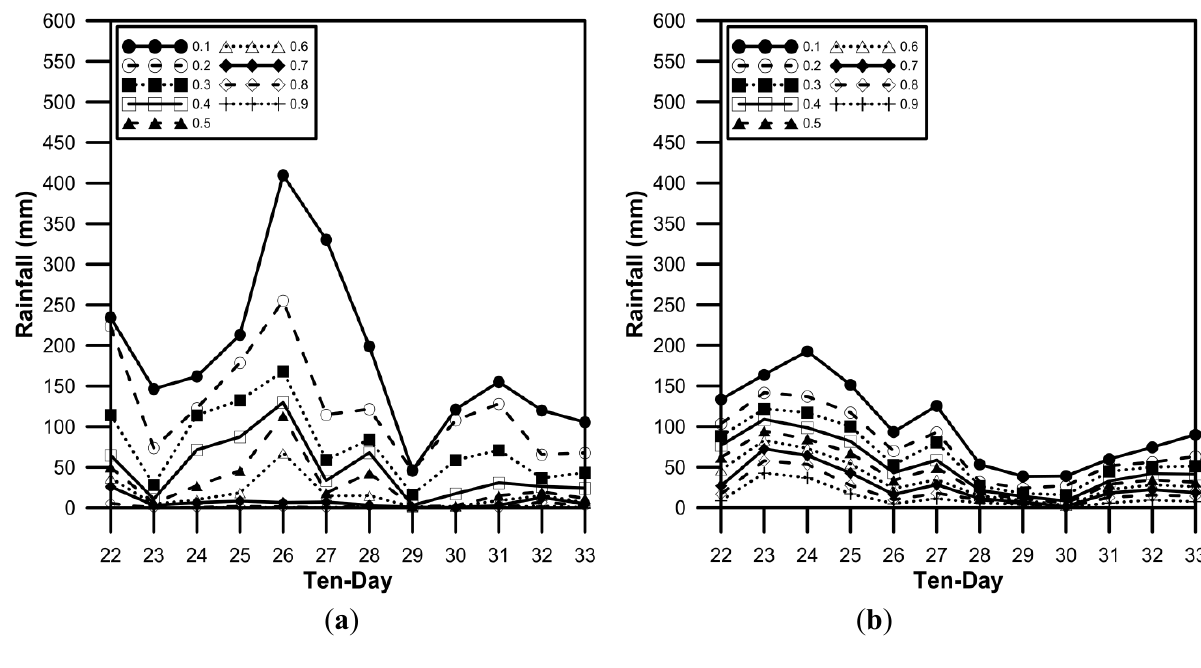
Figure 14. Exceedance probability distribution of rainfall at each ten-day during